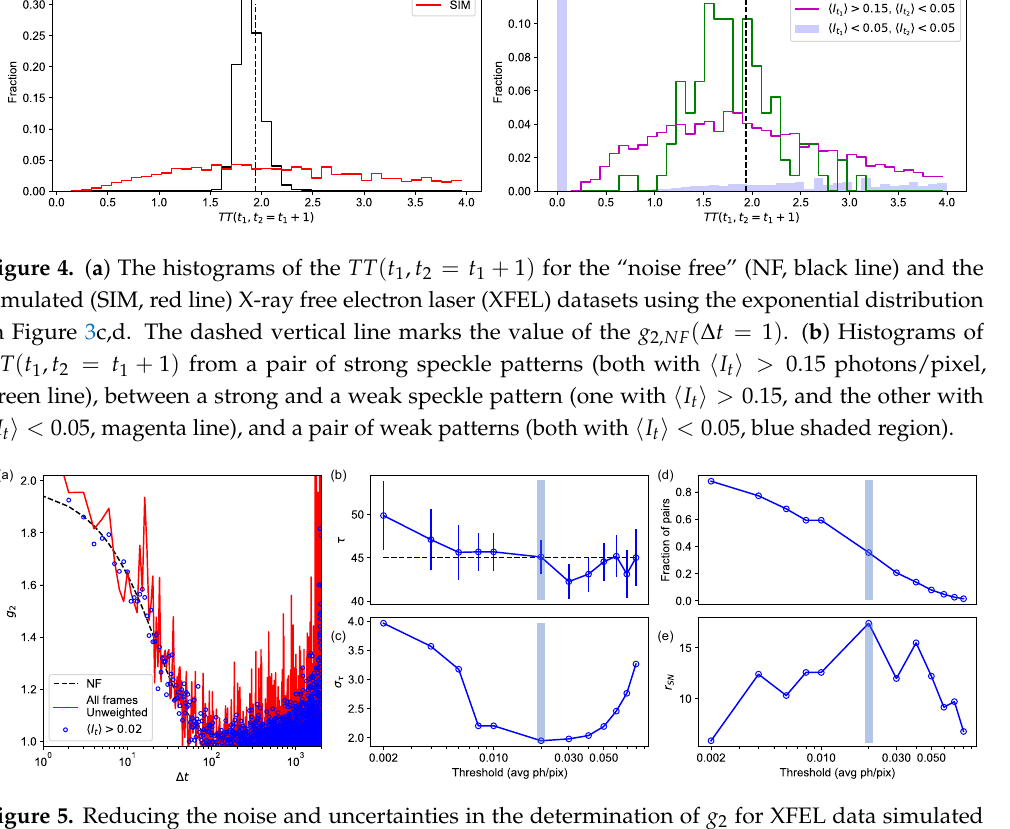
Figure 5. Reducing the noise and uncertainties in the determination of g 2 for XFEL data simulated using the exponential intensity distribution. ( a ) The g 2, SIM calculated from all the speckle patterns (red curve) and only from those over a threshold of 0.02 photon/pixel on average (blue symbols). ( b , c ) The characteristic time scale τ SIM and its standard deviation σ τ extracted from g 2, SIM as a function of the applied intensity threshold, in units of average photon number/pixel. ( d , e ) The fraction of two-time pairs at ∆ t = 1 and the extracted SNR r SN as a function of the applied intensity